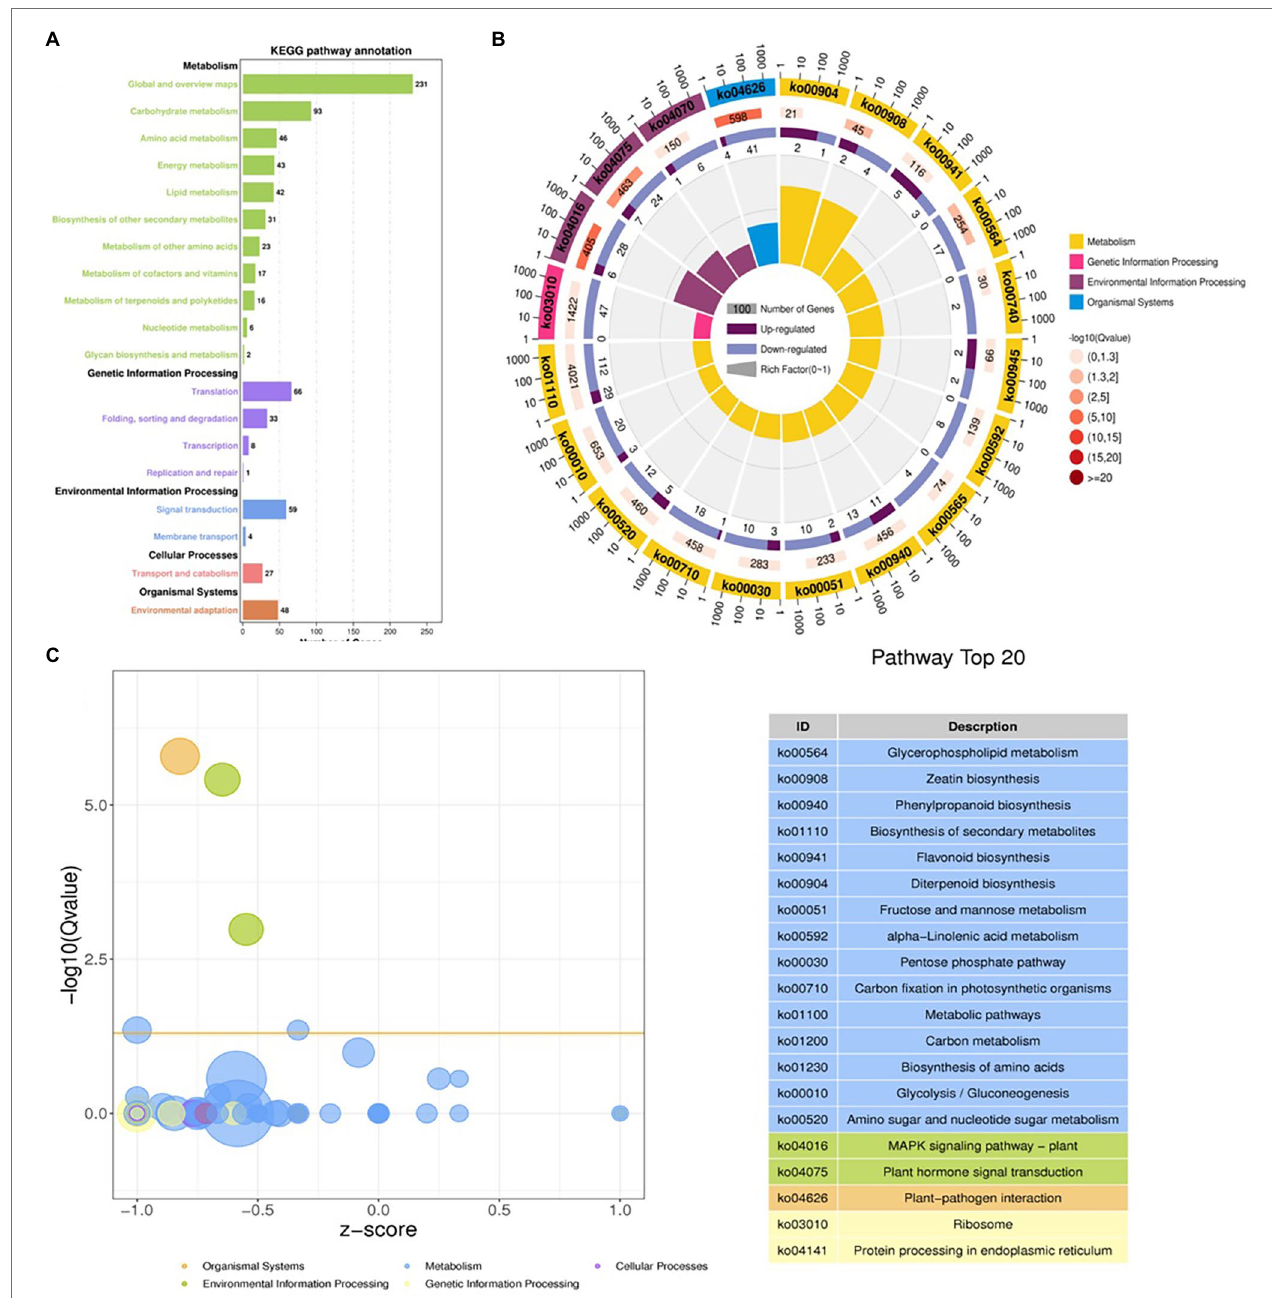
FIGURE 9 | Distributions of the KEGG pathways. Putative proteins were mapped to the reference canonical pathways in the KEGG database. The bar chart shows the number of sequences in different pathway categories (A) , KEGG Rich Circle Map (B) , Bubble plot for visualizing top 20 KEGG Annotation (C) . The z-score predicts existence of a bias in gene